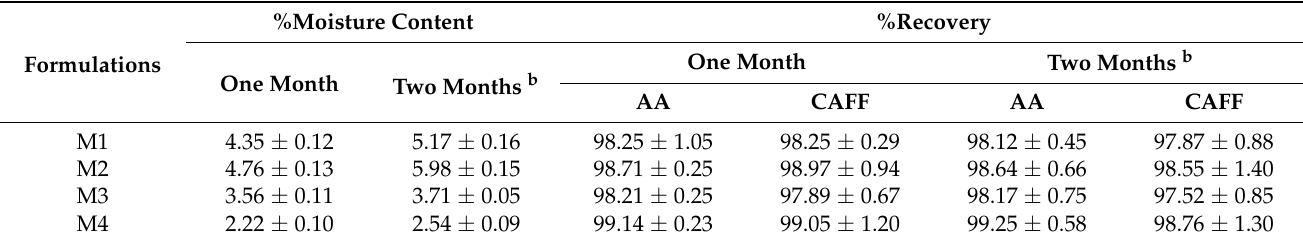
Table 7. Moisture content percentage and recovery percentage for M1, M2, M3 and M4 after one- and two-months a